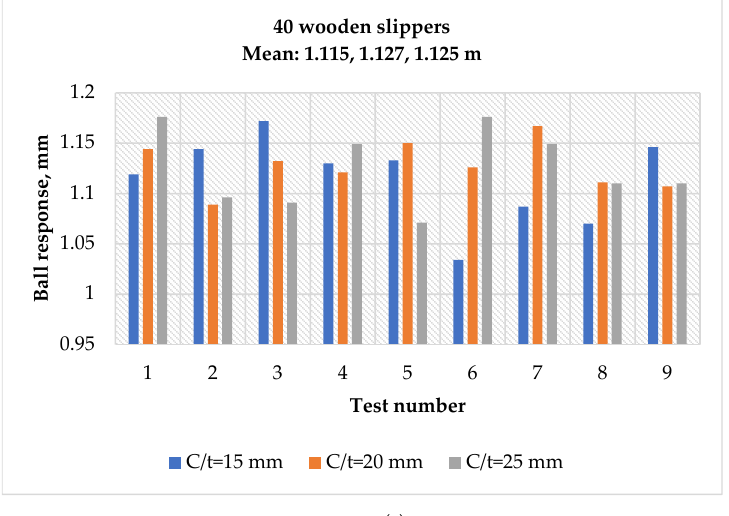
Figure 11. Ball response for C structure: ( a ) 13 wooden slippers; ( b ) 25 wooden slippers; ( c ) 40 wooden slippers.